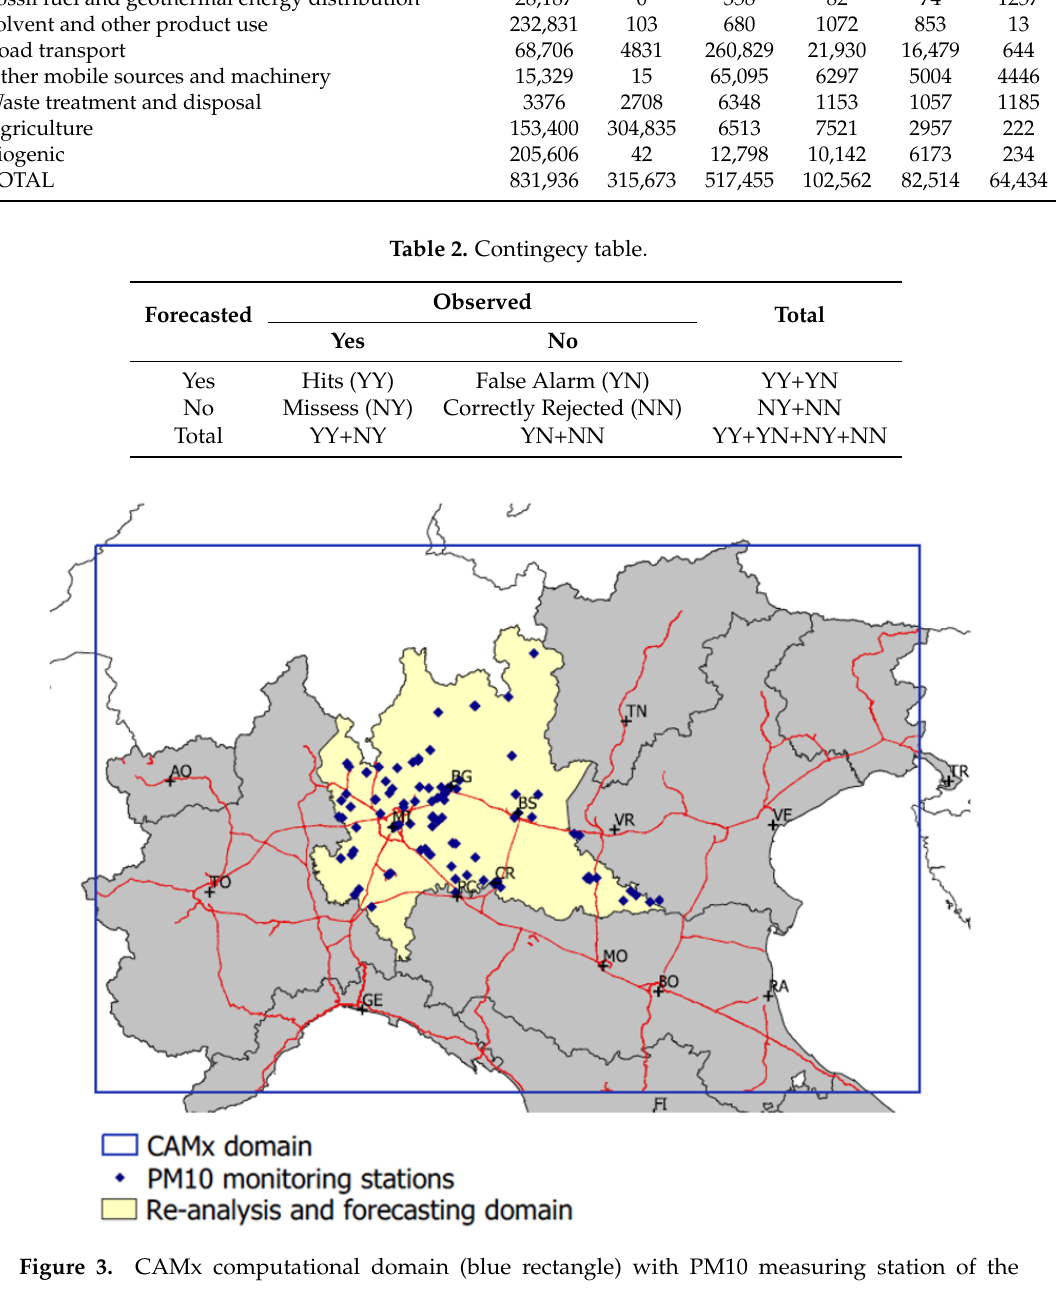
Figure 3. CAMx computational domain (blue rectangle) with PM10 measuring station of the Lombardy region monitoring network (blue dots) and re-analysis and forecasting techniques computing domain